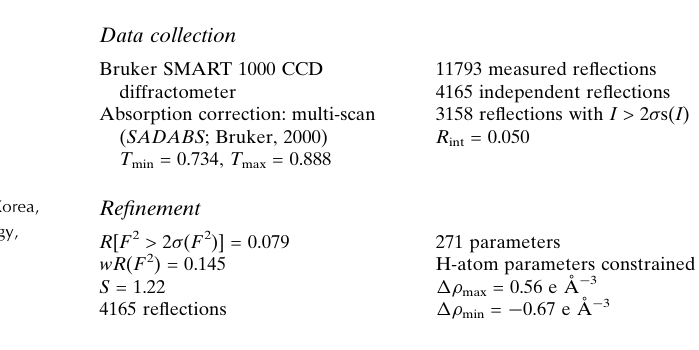
Key indicators: single-crystal X-ray study; T = 243 K; mean (cid:1) (C–C) = 0.008 A˚; disorder in main residue; R factor = 0.079; wR factor = 0.145; data-to-parameter